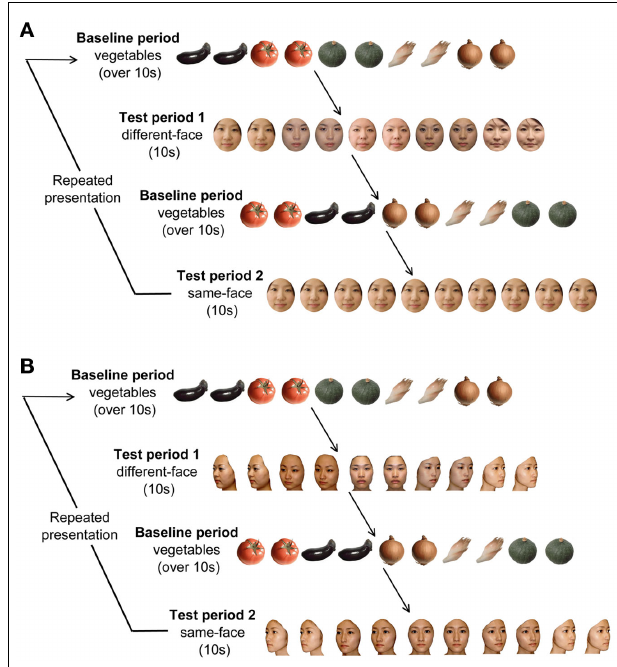
FIGURE 1 | (A) Experimental procedure in Experiment 1. In each trial, the baseline period consisted of stimuli of images of five vegetables, and its duration was at least 10s.The test period consisted of two conditions presenting frontal faces: the same-face condition and the different-face condition.The duration of the test period was fixed for 10s.The presentation order of test period 1 and 2 were changed alternately for each infant. (B) Experimental procedure in Experiment 2.The test period consisted of two conditions under the multiple viewpoint presentation: the same-face condition and the different-face